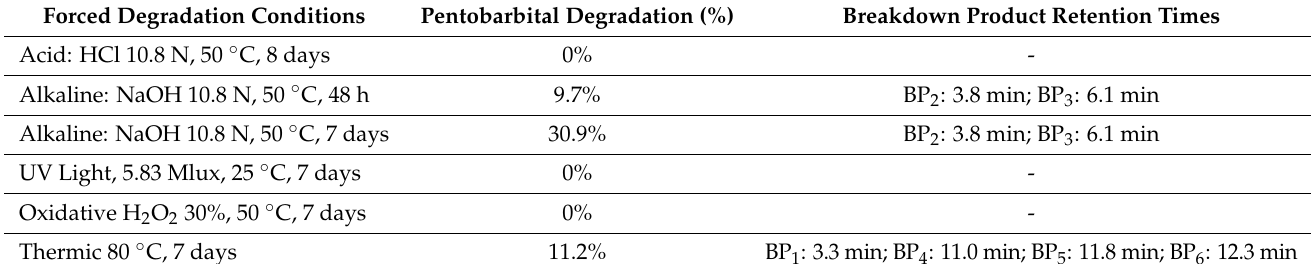
Table 5. Forced degradation results. BP: breakdown product.